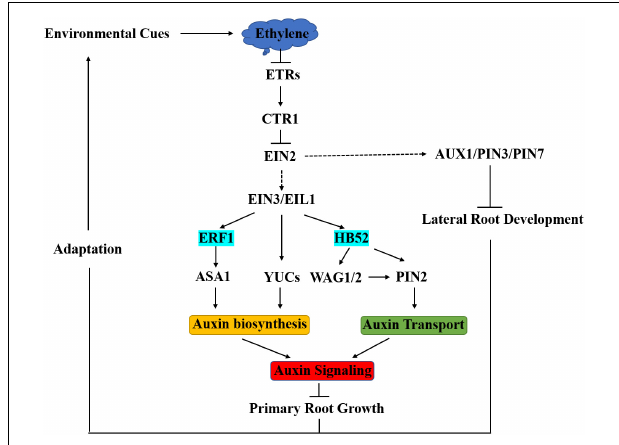
FIGURE 2 | Integration of JA into Auxin Signaling in Arabidopsis Root Development. Plants generate JA in response to environmental cues. COI1 receptor perceives JA, and then recruits JAZs subjected to degradation. Subsequently, MYC2 can activate transcription of early JA-responsive genes. JA promotes lateral root formation by regulating auxin biosynthesis (via ASA1 and YUC2) and transport (via PID and PIN2/4). Transcription factor ERF109 functions as a key crosstalk node in this process. JA inhibits primary root development by repressing the expression of PLT1 and PLT2 . Auxin modulates JA homeostasis by regulating GH3.3/5/6 through ARF6/8/17, then influences adventitious root formation. Therefore, the ERF109 regulatory module plays critical roles in the growth and development of lateral, primary and adventitious roots in the adaptive response of the root system to environmental